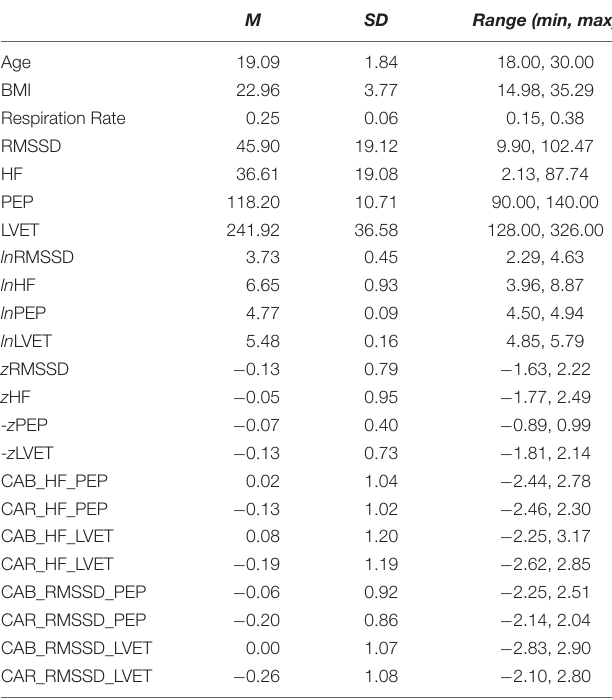
TABLE 1 | Descriptive statistics of variables of interest.